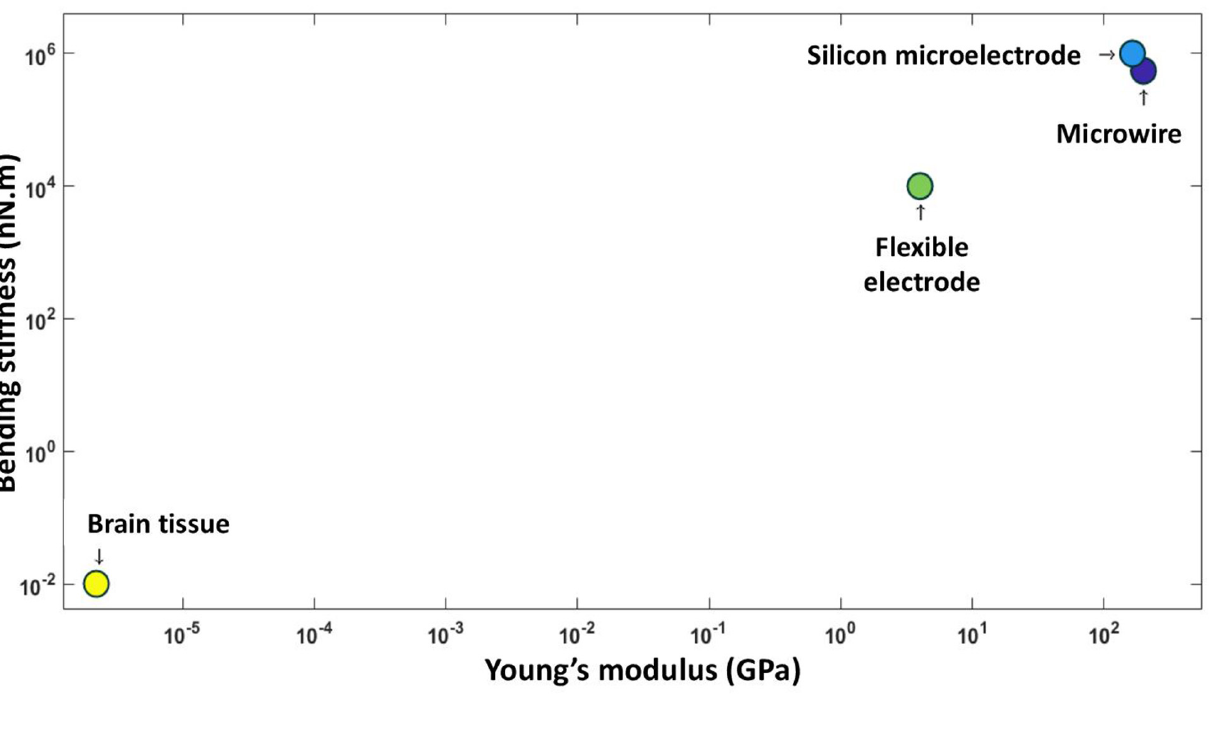
FIGURE 10 | Mechanical properties of brain tissue and three commonly used electrode materials.